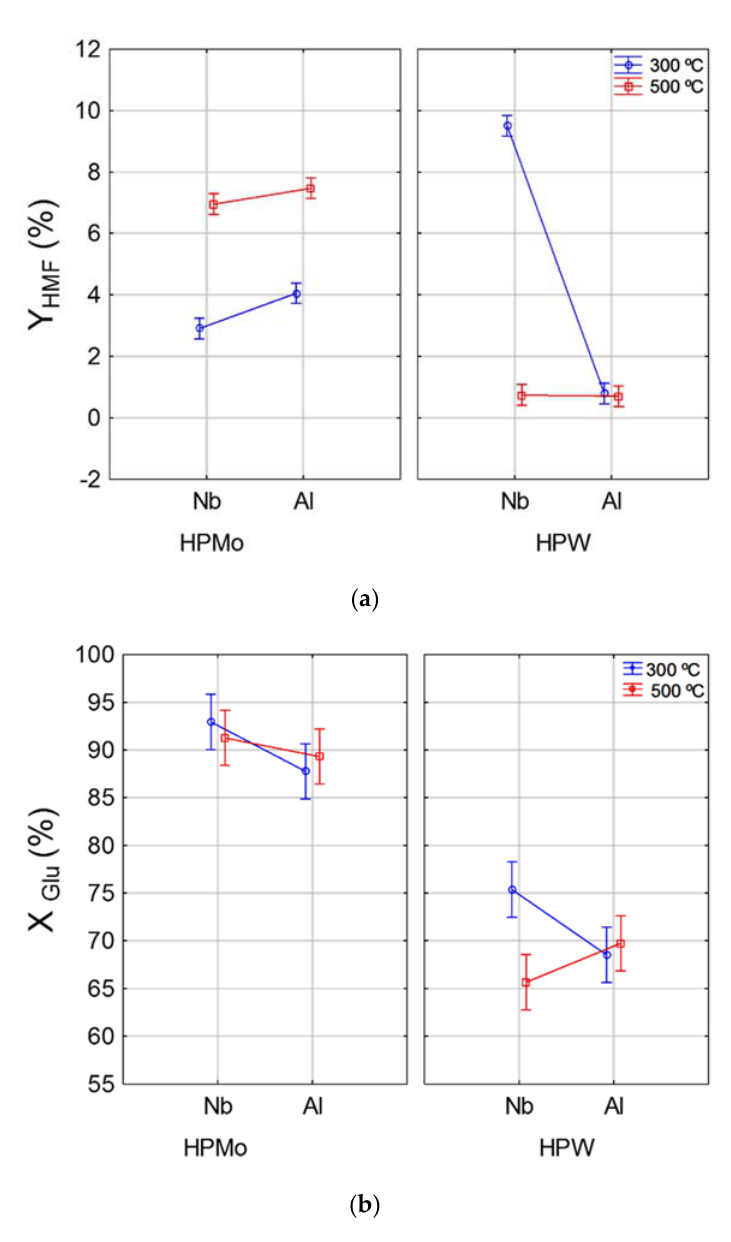
Figure 1. Interaction effect between temperature and support for different active phases (HPW and HPMo) on HMF yield (Y HMF ) ( a ) and glucose conversion (X Glu ) ( b ).